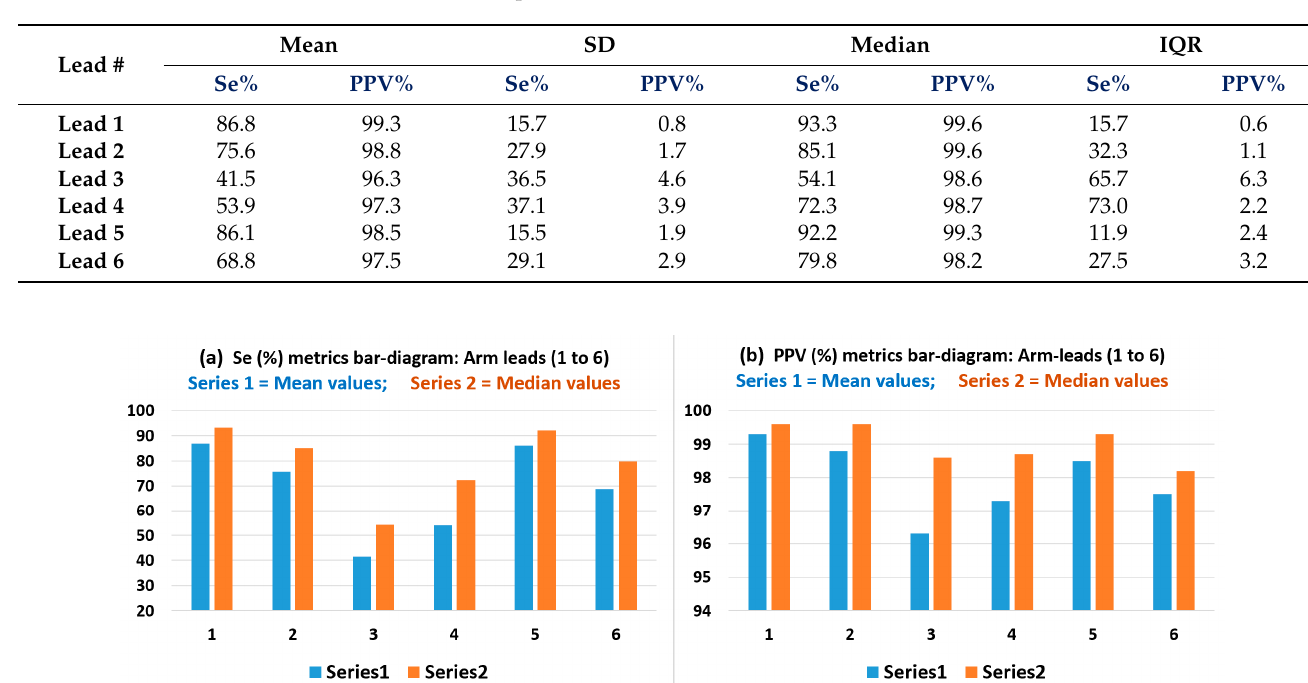
Table 4. Statistics summary of PT based arm-ECG QRS detection performance analysis results on the six bipolar arm lead derivations: mean value, SD, median and IQR results from the 18 subjects after outlier removal operation.